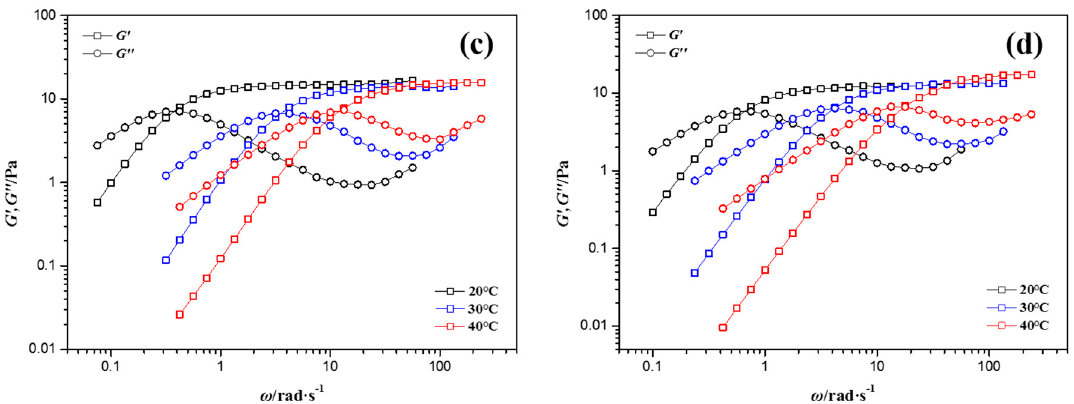
Figure 3. Linear viscoelastic spectrum of NEWMS at different temperatures as a function of silica nanoparticle mass fractions ( a ) 0 wt % silica; ( b ) 0.1 wt % silica; ( c ) 0.3 wt % silica; and ( d ) 0.5 wt % silica.